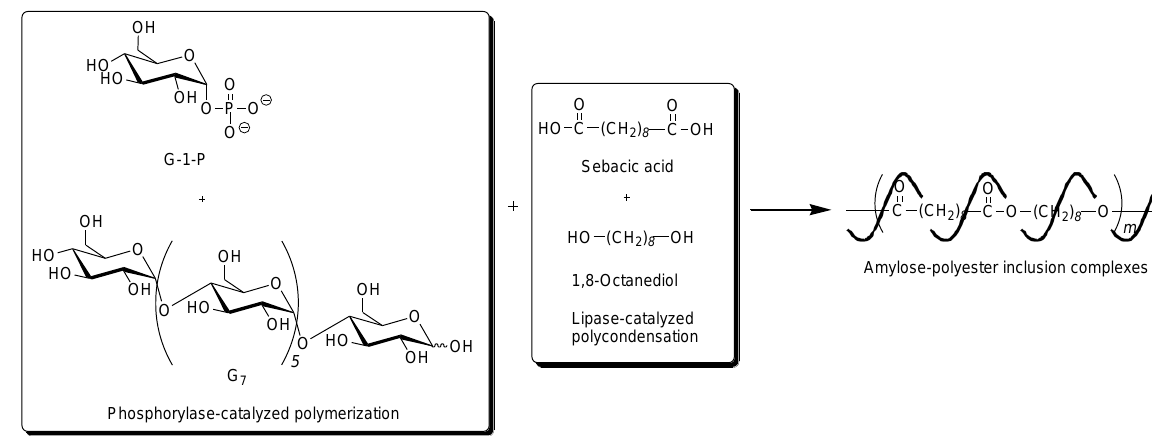
Figure 9. Architecture of inclusion complexes composed of amylose and strongly hydrophobic polyester in parallel enzymatic polymerization